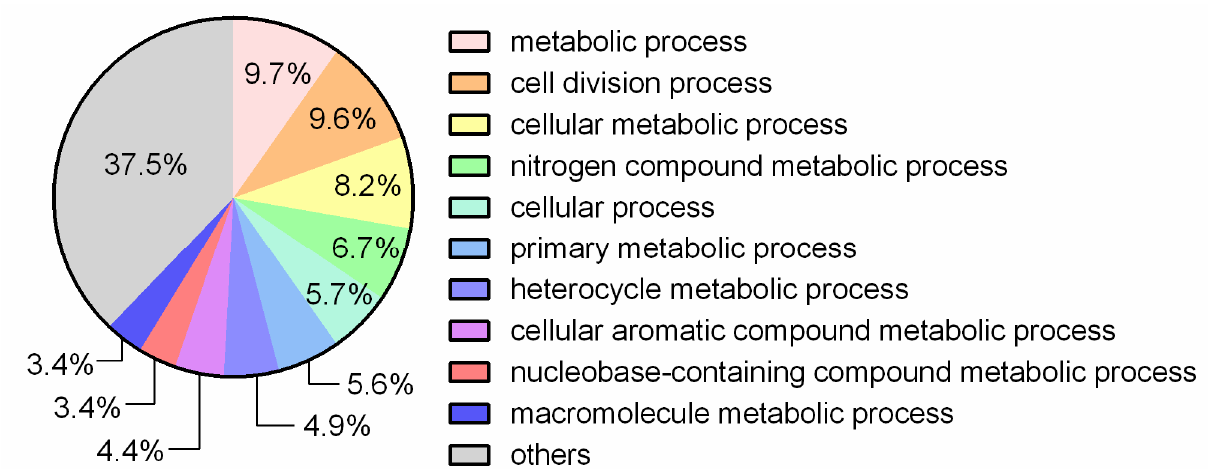
Figure 4. Processes related to proteins belonging to the clusters shared by the L. fermentum strains ATCC 23271, 2760, 3872, CECT 5716, AGR 1485 and DR 9.